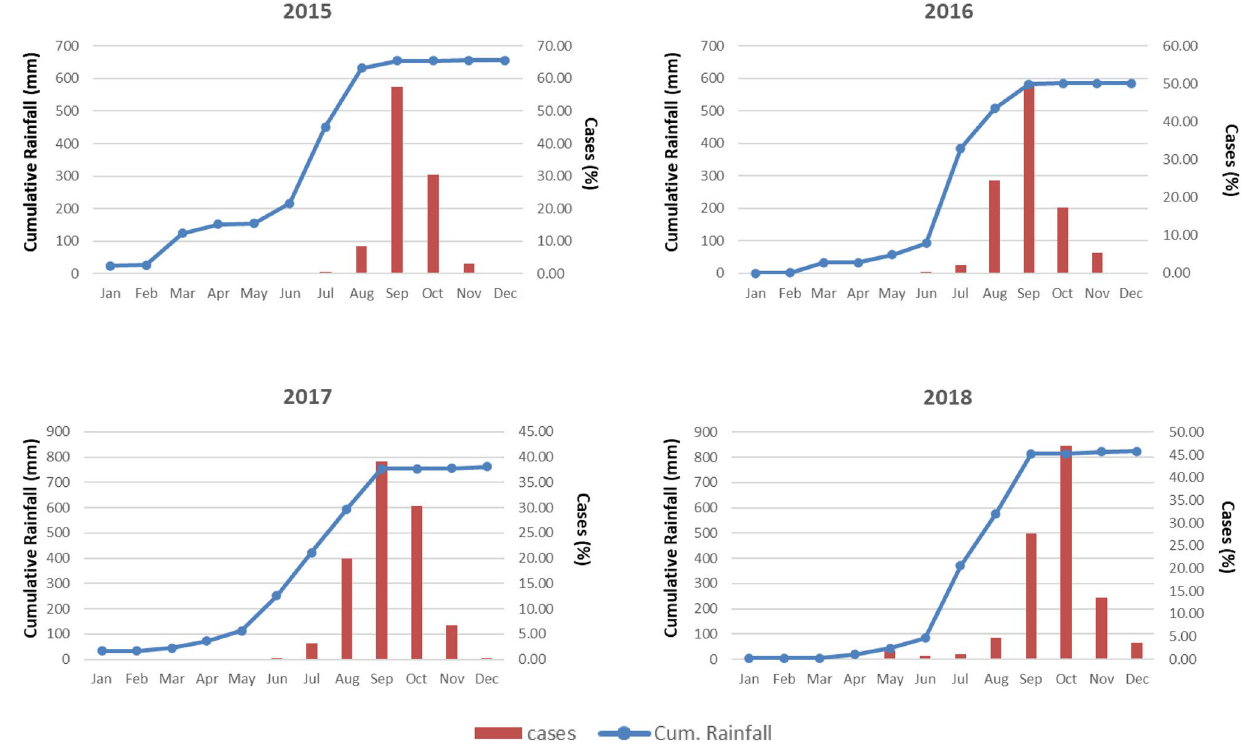
Figure 3. Monthly occurrences of dengue cases and cumulative rainfall, 2015–18, Delhi, India.